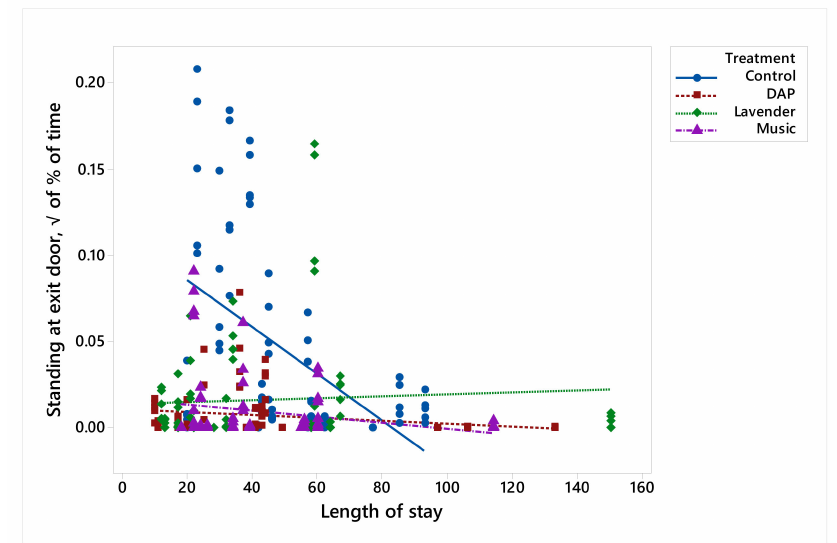
√ % of time standing at exit door of dogs ( n = 60) from